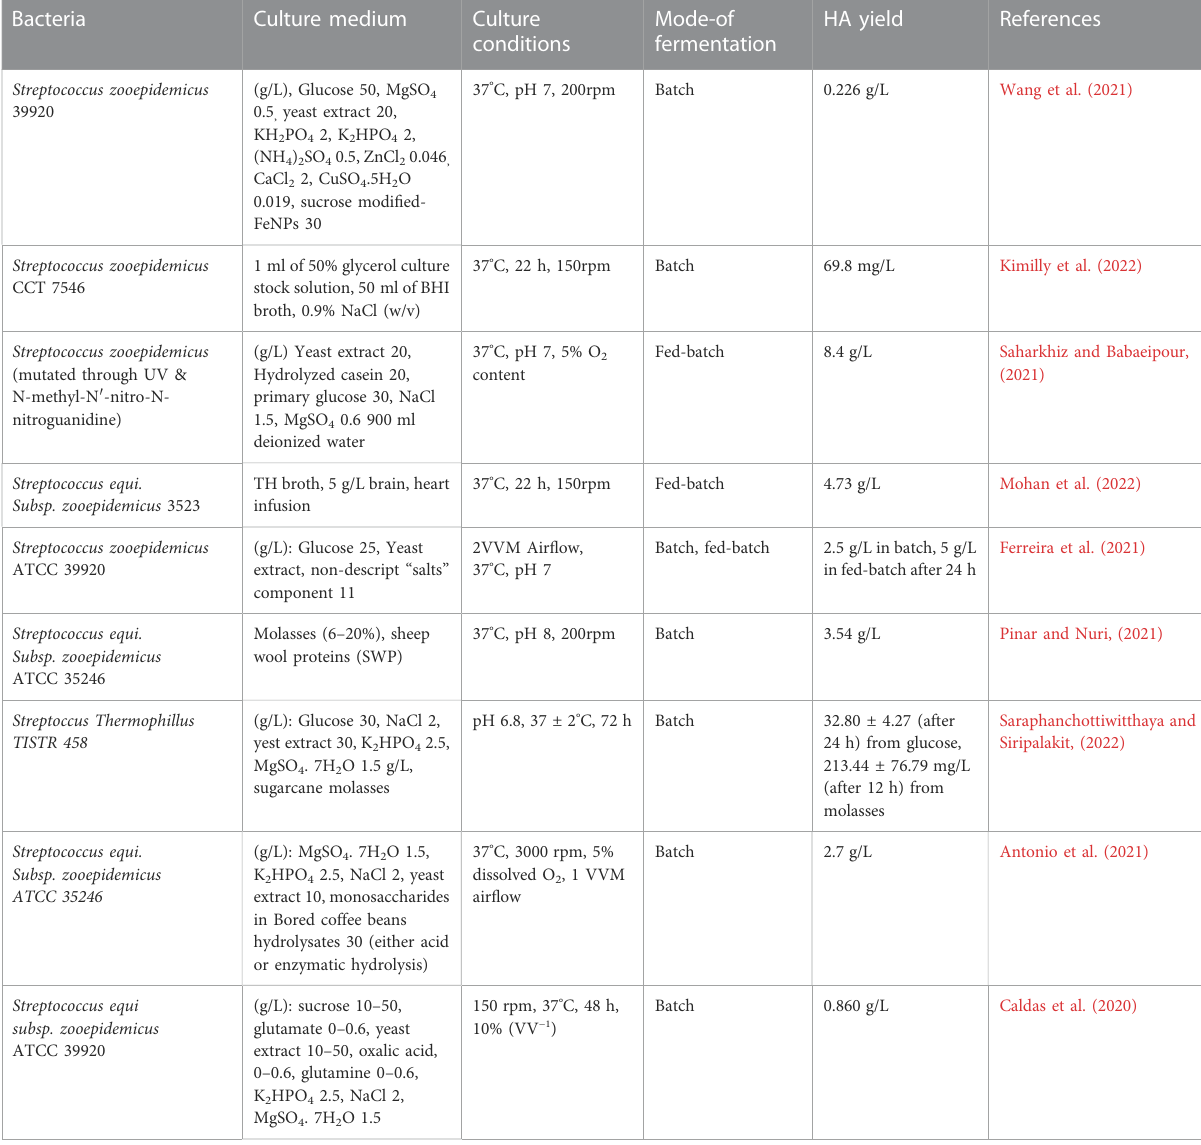
TABLE 1 Some recently cited protocols in literature for microbial production of HA via fermentation.